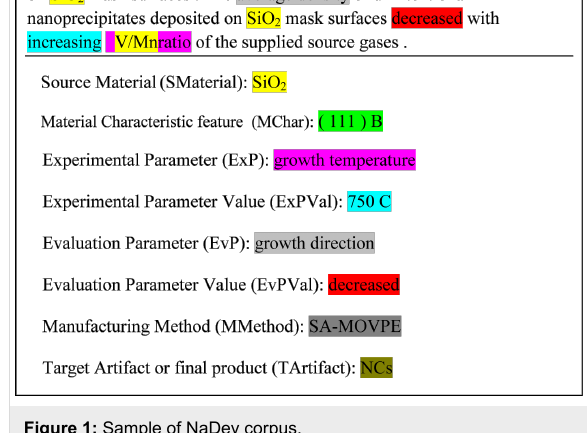
Figure 1: Sample of NaDev corpus.